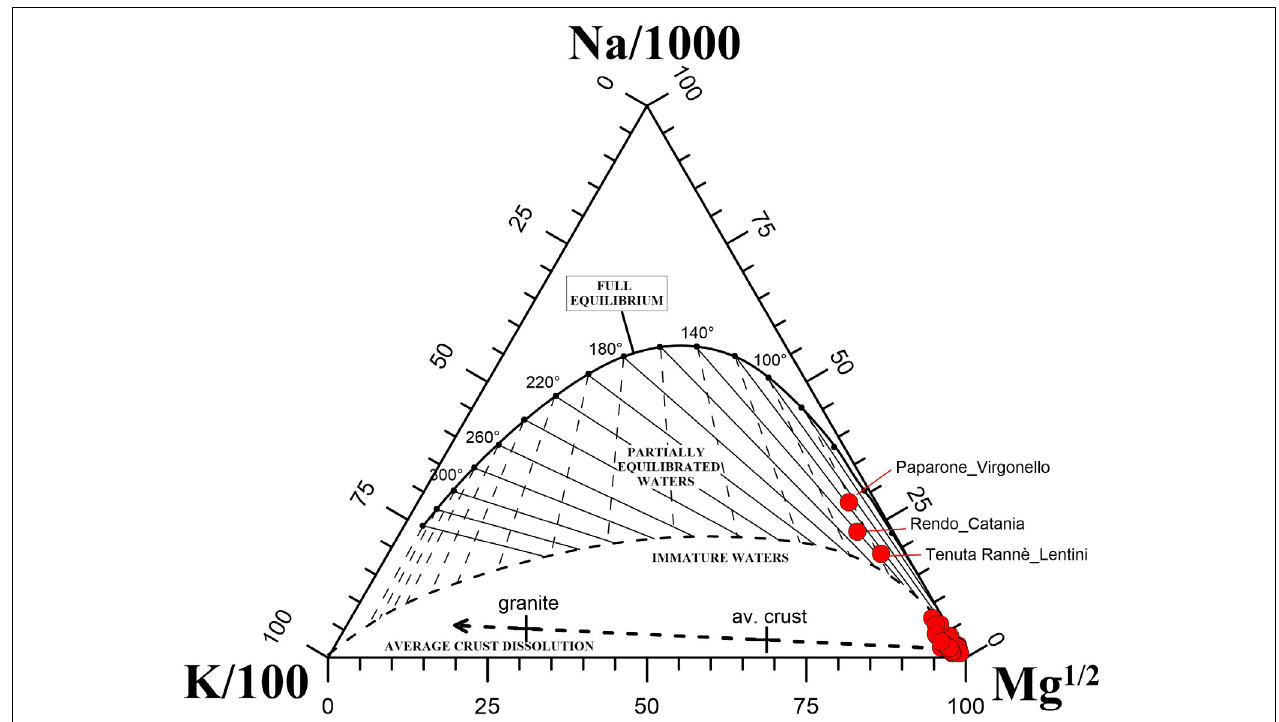
FIGURE 5 | K-Mg-Na ternary diagram (modified from Giggenbach, 1988) for the 33 selected water samples in the area investigated. Samples showing conditions of partial equilibration are indicated with their name.